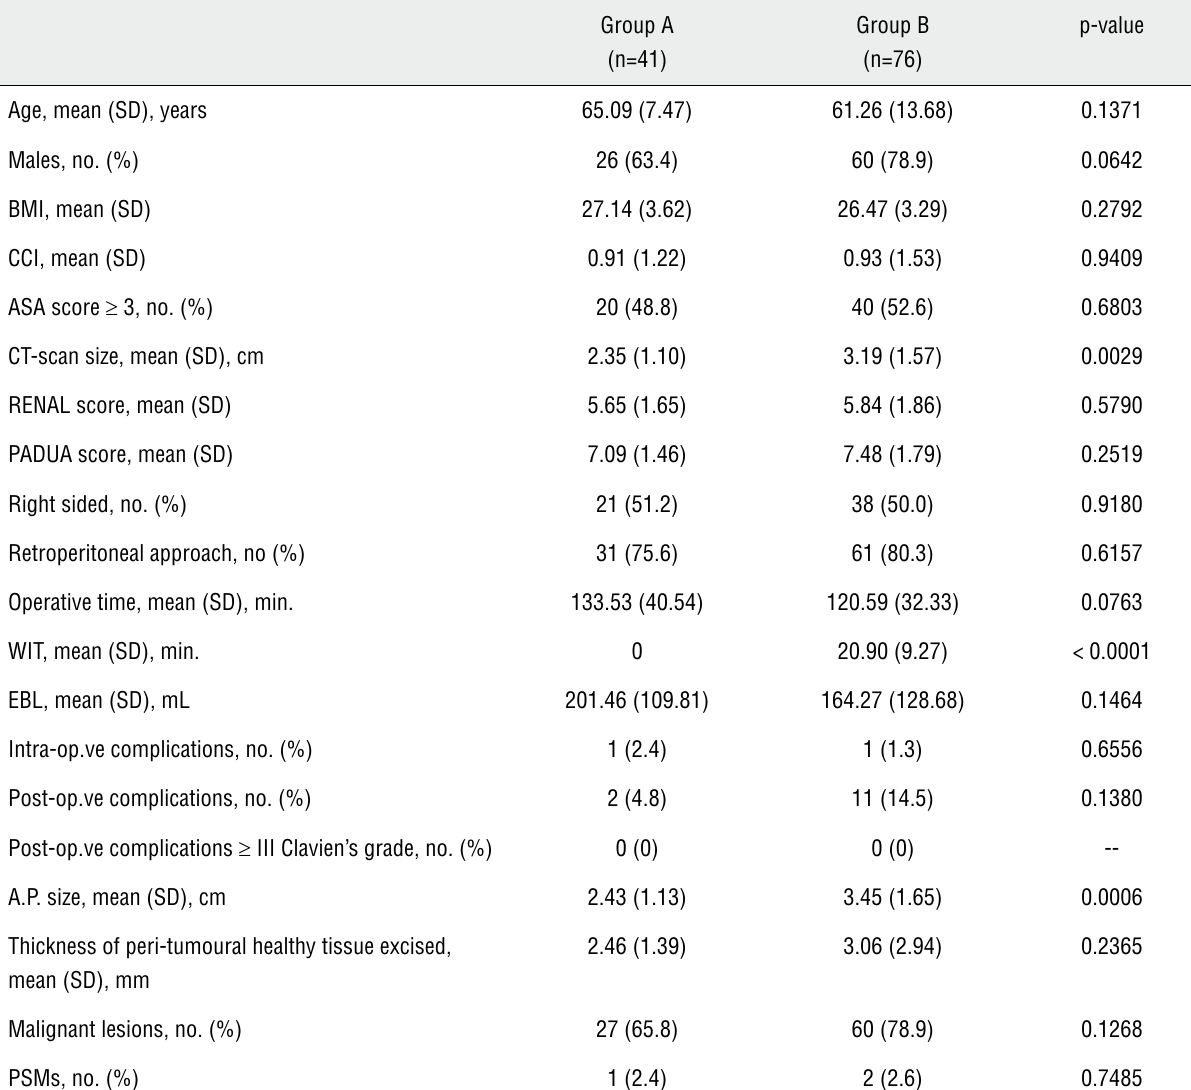
Table 1 - Demographic, peri-operative, post-operative variables and